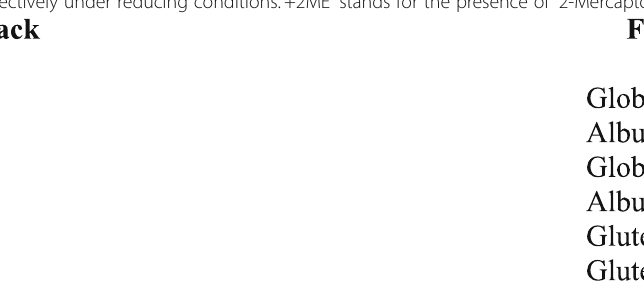
Fig. 3 SDS-polyacrylamide gel electrophoresis of seed protein fractions of cotton lines ‘ F-2228 ’ and ‘ FDK-124 ’ of G. hirsutum and G. arboreum, respectively under reducing conditions. ‘ +2ME ’ stands for the presence of ‘ 2-Mercaptoethanol